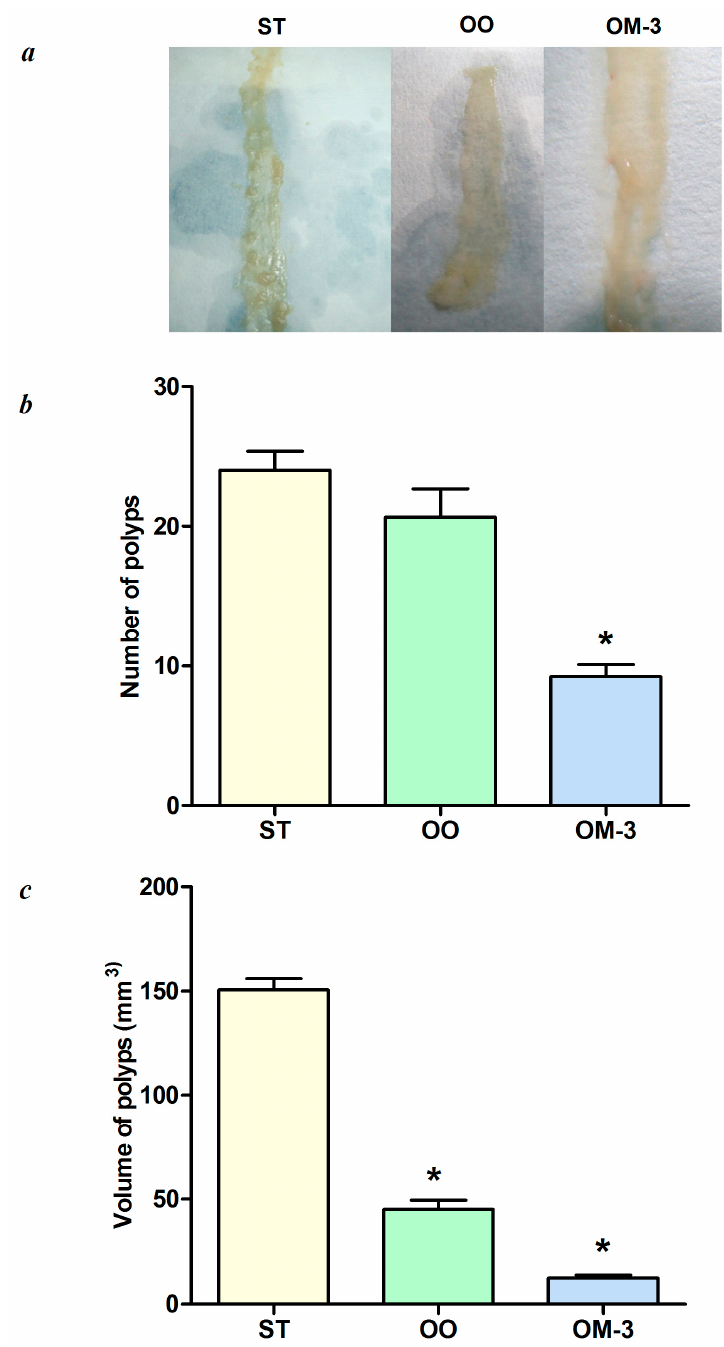
Figure 1. ( a ) Macroscopic view of intestinal tumors in the groups of mice that received three different dietary treatments; ST = standard diet; OO = standard diet with 12% olive oil; OM-3 = standard diet with 12% of salmon fish with a rich content of ω -3 PUFAs; ( b ) total number of intestinal polyps in the three mice treatment groups; ( c ) total volume of intestinal polyps in the three mice treatment groups. Data are presented as the mean ± SE. * p < 0.05 (ANOVA and Dunnett’s multiple comparison test, each experimental group vs. the ST group).